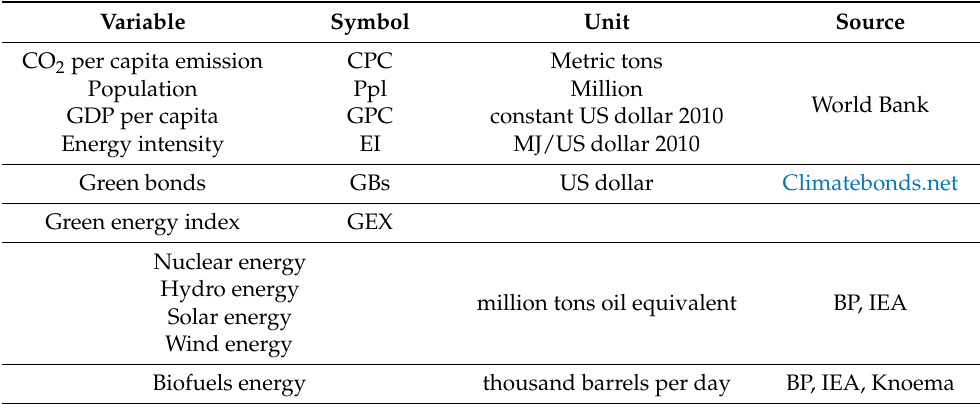
Variable Symbol Unit Source CO 2 per capita emission CPC